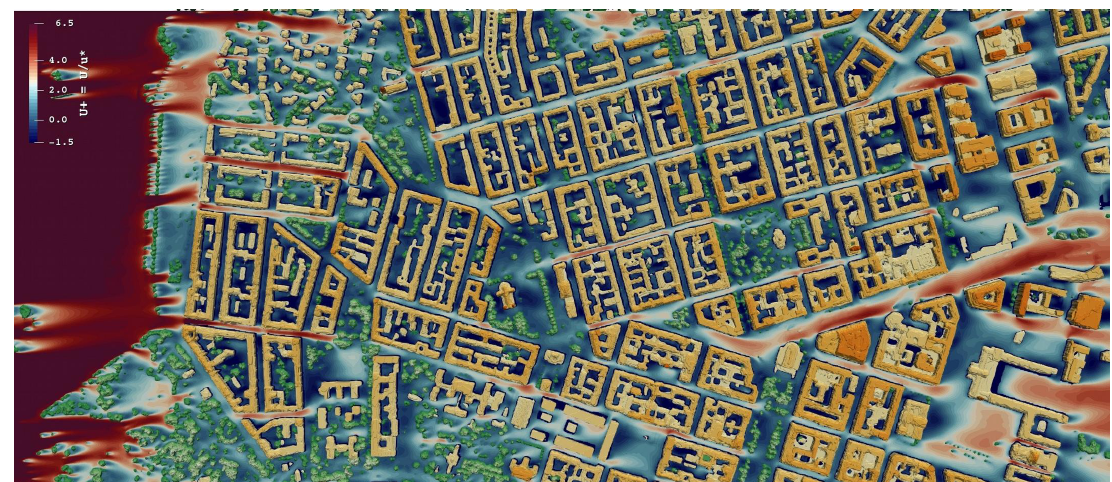
Figure 6. Horizontal distribution of u + Ω ( 2 ) domain featuring ∆ = H /10